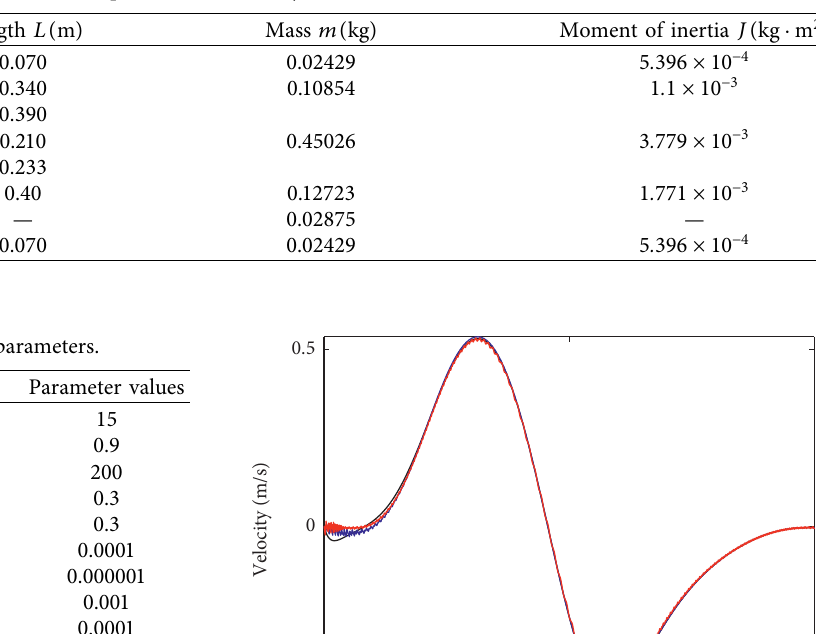
Table 2: Geometric and inertial parameters of the hybrid driven seven-bar mechanism.